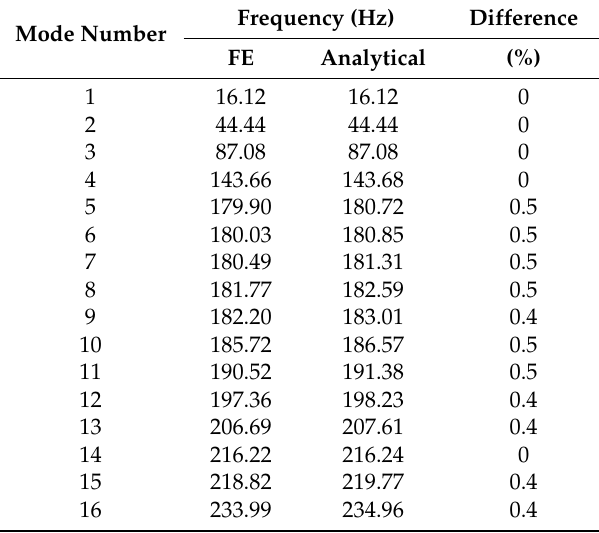
Table 4. Modal frequencies for the fixed-fixed double-beam